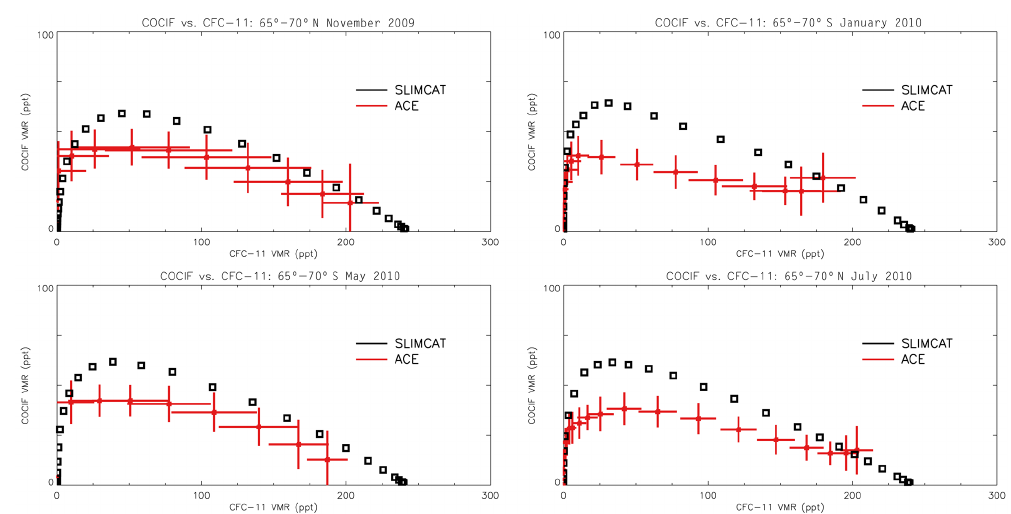
Figure 5. Correlation plots between coincident CFC-11 and COClF ACE-FTS observations and SLIMCAT calculations for Novem-